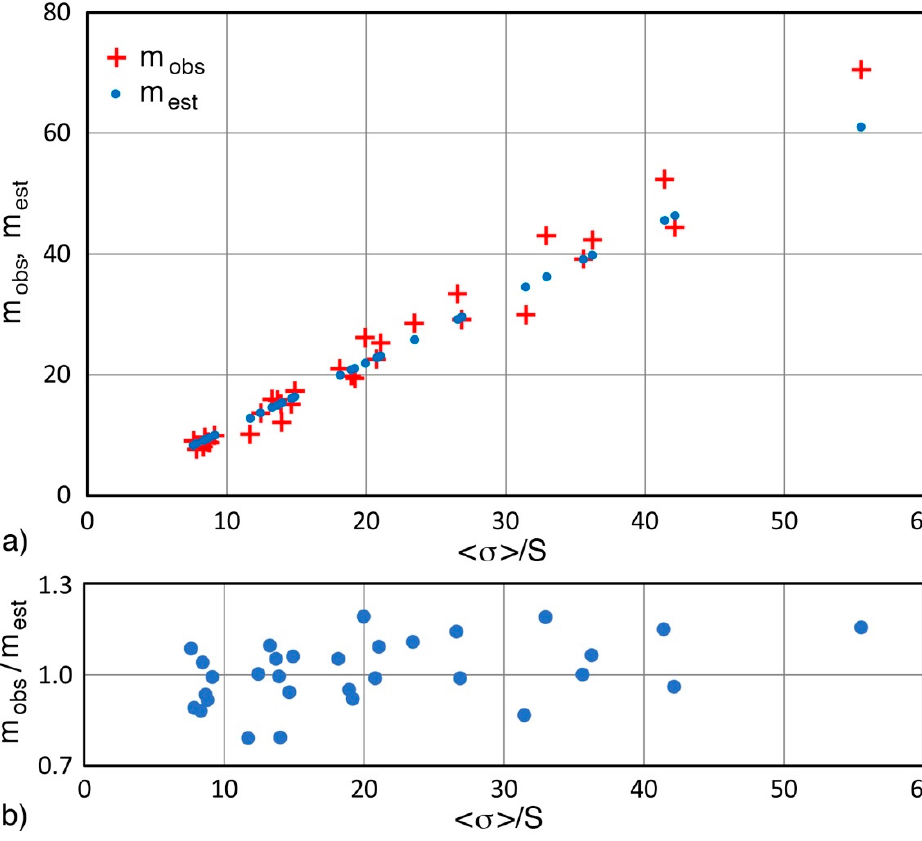
Figure 4. ( a ) Plots of m obs (red + symbol) and m est (blue dot) vs. < σ >/ S for the historical iron and steel datasets. ( b ) Plot of m obs / m est (blue dot) vs. < σ >/ S for the same.